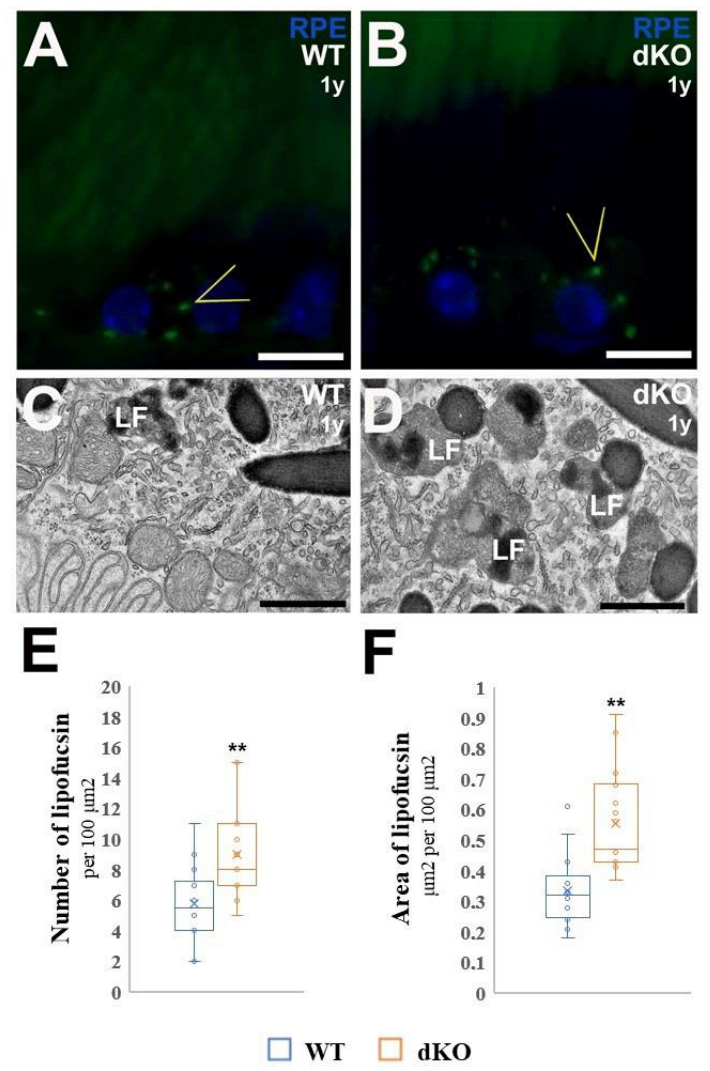
Figure 6. Confocal microscopy of lipofuscin (LF) autofluorescence and quantitative TEM analysis of lipofuscin granules in wild-type (WT) and dKO RPE. Sections from WT and dKO mice were analyzed by fluorescence microscopy. Arrowheads point to LF granules within RPE cytoplasm of one-year-old WT ( A ) and dKO mice ( B ). In contrast to WT, dKO RPE showed increased levels of LF fluorophores. Transmission electron microscopy was used for quantitative analysis of polymorphic lipofuscin granules in WT ( C ) and dKO ( D ) samples. Considerable accumulation of the number of LF granules was detected in dKO samples. The lipofuscin granules in the cytoplasm of RPE and decrease of organelles were observed; most LF granules resulted to be completely occupied by strongly electron-dense substance ( E ). The average area of LF granules increased within the RPE of dKO samples per 100 µ m 2 area measured from electron micrographs ( F ). ** p < 0.001 (Mann-Whitney U-test). Scale bars: 5 µ m ( A , B ), 0.5 µ m ( C , D ). Finally, we studied EMT’s connection to some senescence markers (Figure